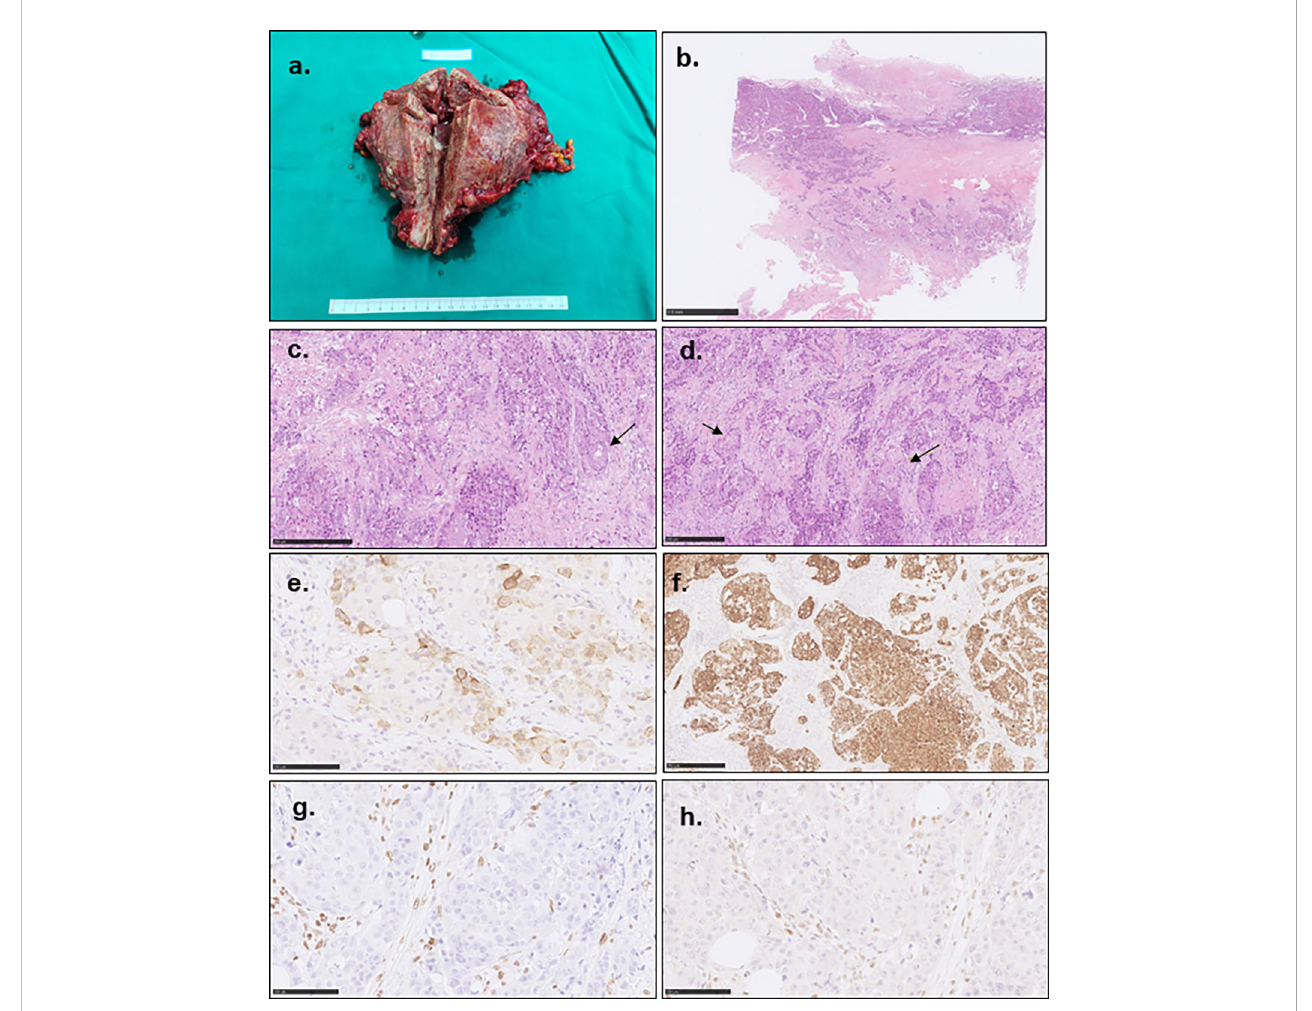
FIGURE 3 Gross photograph and pathological characteristics of the tumor. (A) showed the enlarged uterus. The endometrium was irregularly demolished, and the uterine wall and serous membrane were invaded. (B) showed the poorly differentiated carcinoma cells invaded the whole uterine wall with multiple embolisms. (C) indicated the poorly differentiated carcinoma with focal glandular formation (arrow). (D) showed focal squamous differentiation (arrow). (E) showed focal PTH staining. (F) showed diffusely AE1/AE3 staining. The tumor cells showed MLH-1 (G) and PMS-2 (H) negative staining contrast to the mesenchymal